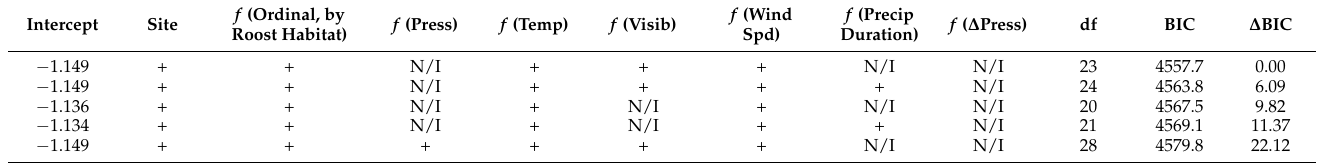
Table 4. Top five competing post-hoc models ranked by Bayesian information criterion (BIC) from acoustic data collected off the Eastern Shore of Virginia, USA, 2012–2019. The model selection dredge contained all possible combinations of site (factor, 5 levels), smooth effects, f ( x ), of ordinal date (1–365; one for each roost availability type [viable, limited]), and smooth effects of nightly mean pressure (mmHg), temperature (C), visibility (0–10 mi), and wind speed (m/s), total precipitation duration (hours), and change in pressure from the previous night. N/I indicates no inclusion in that particular model. Terms with “+” indicate inclusion of that term in the model as a smooth function. We displayed the model degrees of freedom (df), BIC, and ∆